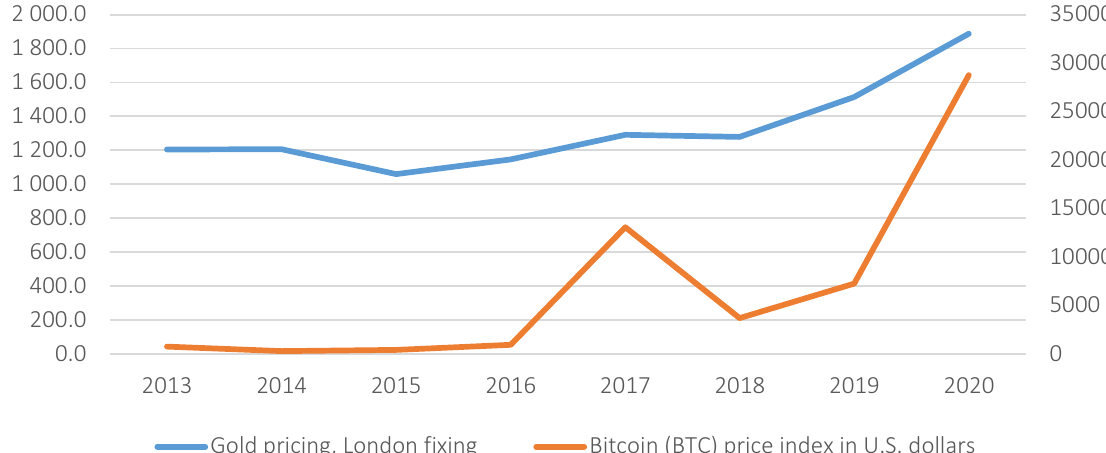
Figure 3. Gold and Bitcoin